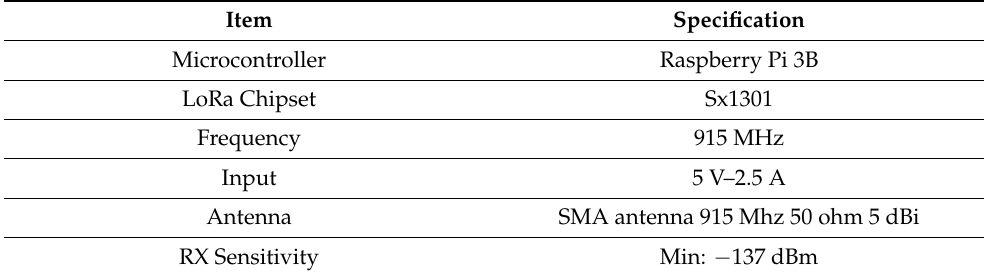
Figure 6. Components of the LoRaWAN ® multi-channel GW. Table 3. Technical specification of the LoRa multi-channel